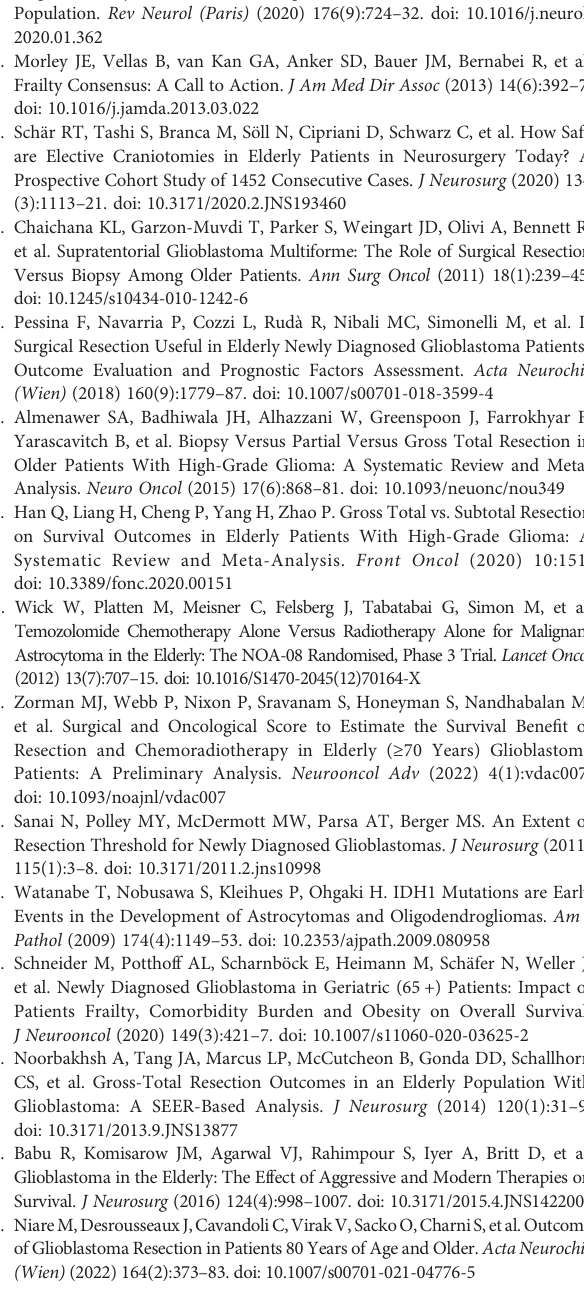
Innsbruck (Protocol number: AN 1333/2021). The patients/ participants provided their written informed consent to participate in this